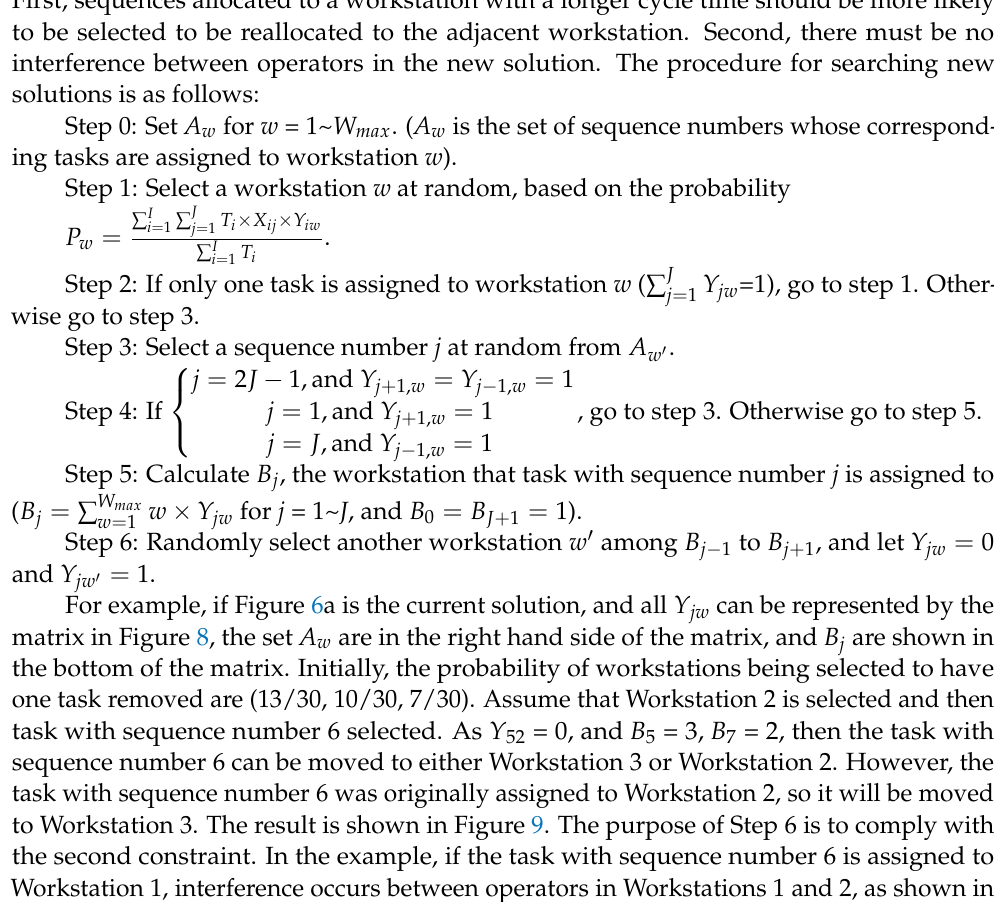
Figure 9. An example result of a new solution. Figure 10. An example result of a new solution with interference. In Step 4, the purpose is to prevent the selection of a task that cannot be allocated to another workstation. If the task with sequence number j is selected, but both sequence number j − 1 and j + 1 are allocated in the same workstation. 𝐵𝐵 𝑗𝑗−1 , 𝐵𝐵 𝑗𝑗 and 𝐵𝐵 𝑗𝑗+1 are the same, and no other workstations can be selected in Step 6. 4.4. Temperature Cooling Temperature is an important parameter for accepting a worse solution in order to escape from a local optimum. This study adopts the cooling function which was introduced by Lundy and Mees [41] as shown in Equation (23). In Equation (23), E h is the temperature in search iteration h , H is the total number of search iterations of SA, and β is the parameter for controlling the cooling speed. Lee et al. [39] mentioned that the cooling function outperforms the commonly used geometric temperature updating scheme. 𝐸𝐸 ℎ+1 =